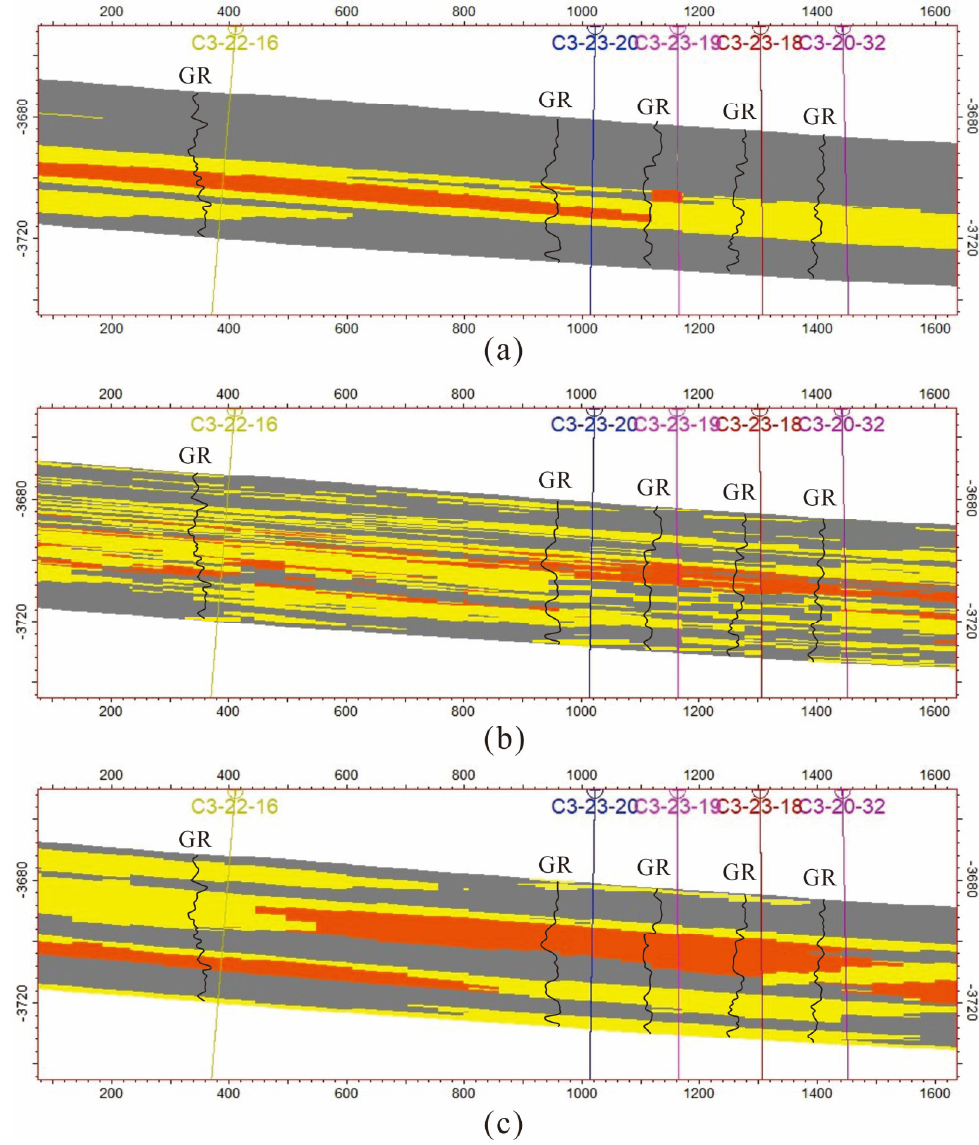
Figure 13. Comparison of simulation results of three methods and well-connecting profile. ( a ) Object-based simulation result; ( b ) SIS result; ( c ) MPS result based on 2D TIs.